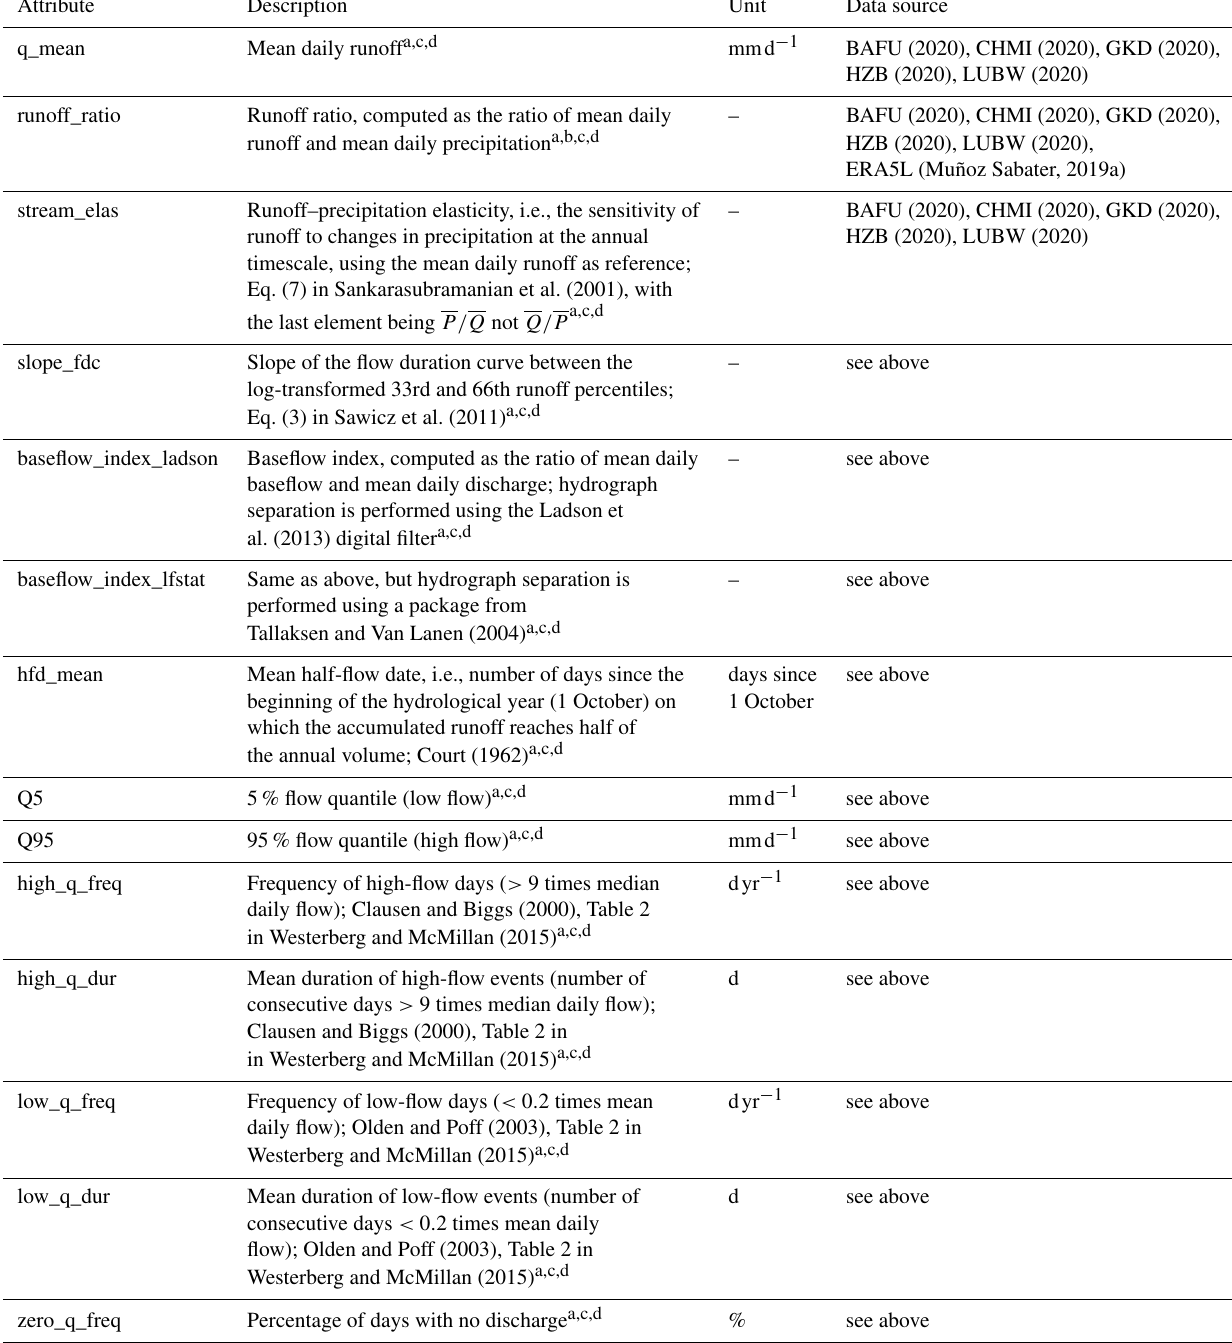
Table A5. Hydrological signatures.